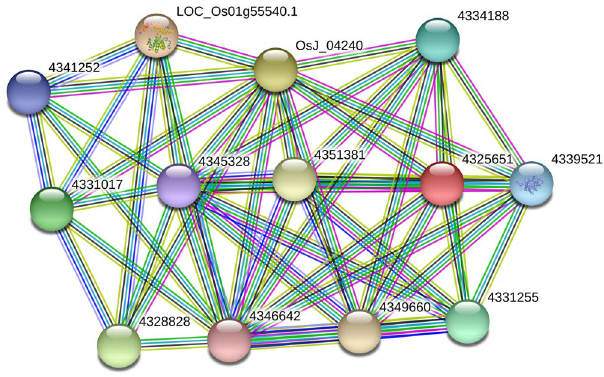
Figure 6. AbSR – ThrMPG molecular interaction network. Japonica rice – AbSR – ThrMPG interaction showing strongly connected functional modules. Colored lines between the proteins indicate various types of interaction evidence. Green color, gene neighborhood; red color, gene fusions; blue color, gene co-occurrence; black color, co-expression; sand green color, text-mining; pink color, experimentally determined; violet color, protein homology. Filled protein nodes that represent the availability of protein 3D structural information is known or predicted.